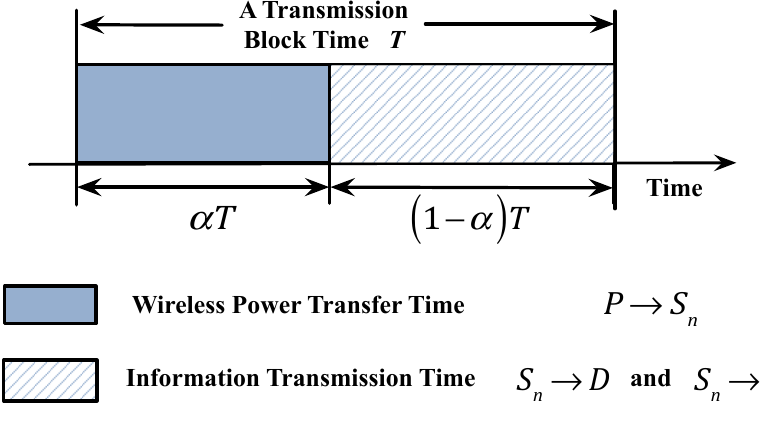
Figure 2. Time-switching